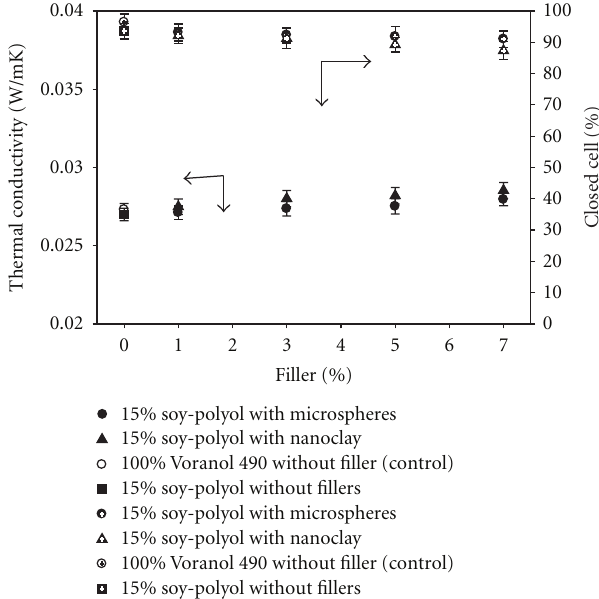
Figure 6: Foaming temperature of control and SBO PUF made from 15% soybean oil-based polyol and modified with micro- spheres.